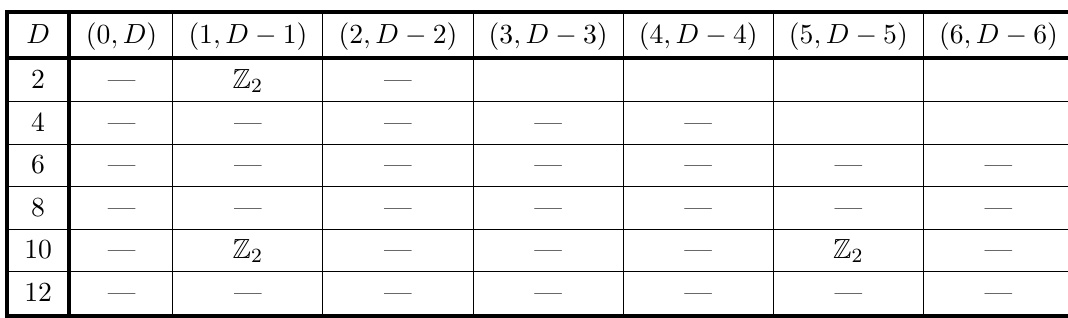
Table 7. In this table we list chiral ( N + , N − ) = (1 , 0) , (0 , 1) supersymmetry algebras, where the supercharges form a single Majorana-Weyl spinor ( d S / such algebras exist, they are represented by their discrete R-symmetry group O (1) ∼ = Z means no such algebra can be